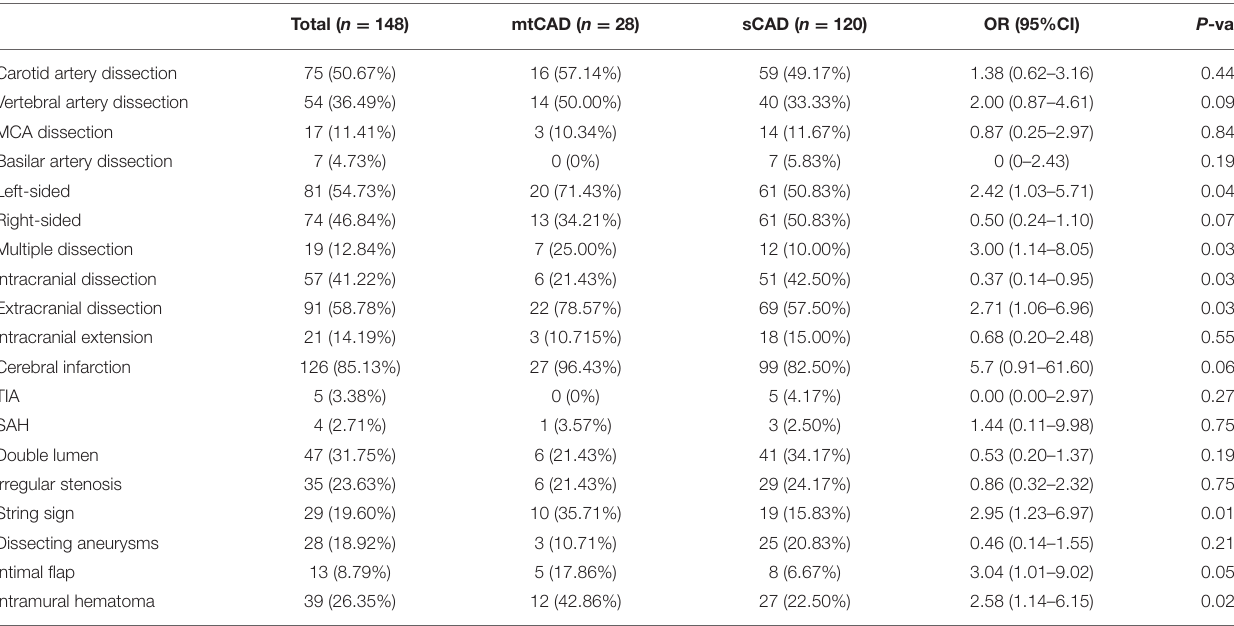
TABLE 2 | Imaging